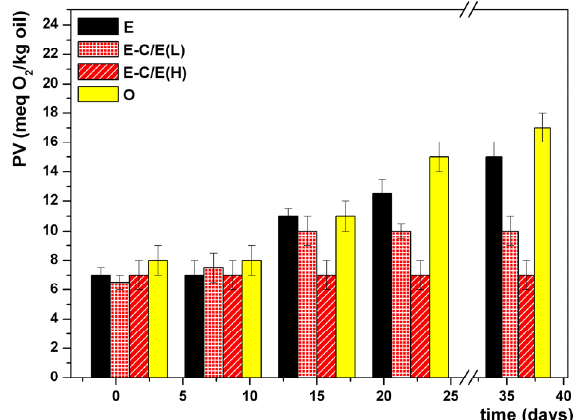
Figure 5. PV as a function of time in: E, w/o emulsion; E-C/E(L) w/o emulsion enriched with low concentration of vitamin C and vitamin E; E-C/E(H) w/o emulsion enriched with high concentration of vitamin C and vitamin E; O, oil (bars represent standard deviation of mean values).